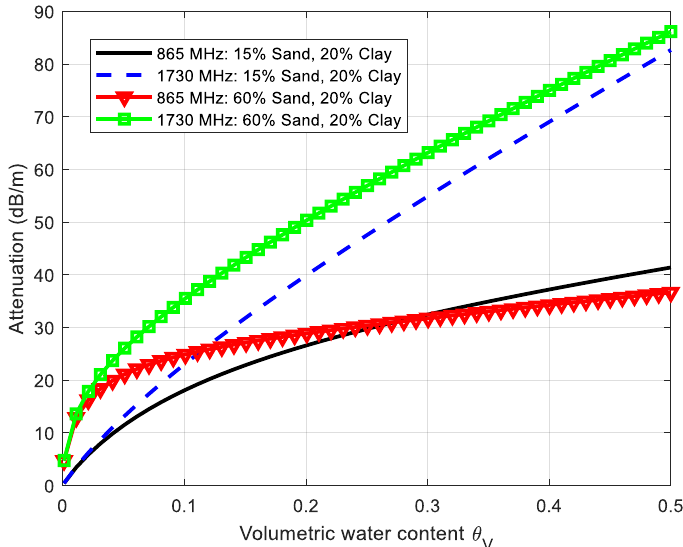
Figure 11. Simulated attenuation coefficient in dB/m calculated from Equations (2) and (3) as a function of the volumetric water content of the soil at 865 MHz and 1730 MHz for two soil cases.